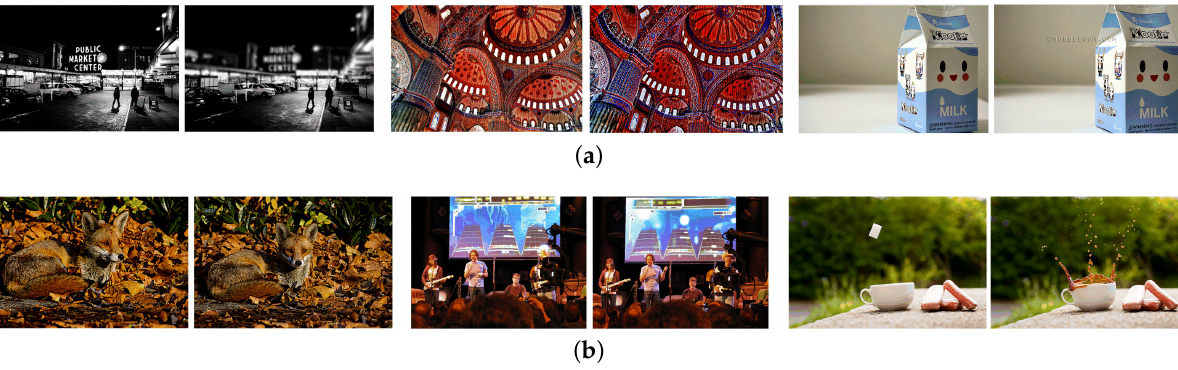
Figure 4. Illustration of near duplicate image pair samples from Mir-Flickr Near Duplicate (MFND). ( a ) Pairs from MFND- identical near-duplicate (IND). From left to right, the changes between near duplicate pairs are focus change, scale change, color tune change, border, and watermark addition. These pairs are extremely visually similar, and there is no displacement or posture change of the objects or background in the images. ( b ) Pairs from MFND-non-identical near-duplicates (NIND).